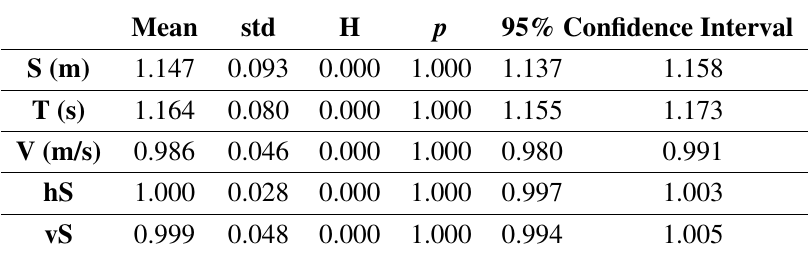
Table 7. Normality test of gait